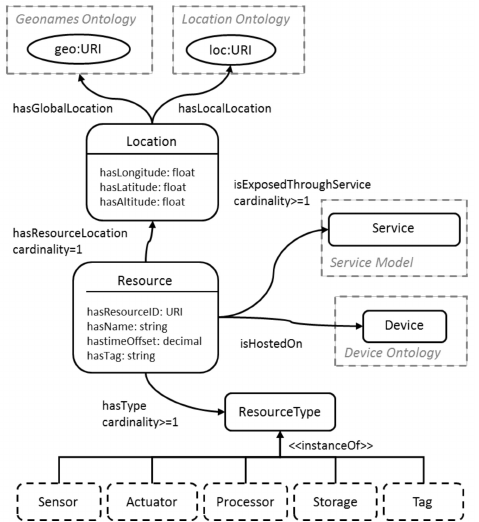
Figure 1. Internet of Things Architecture (IoT-A) Resource